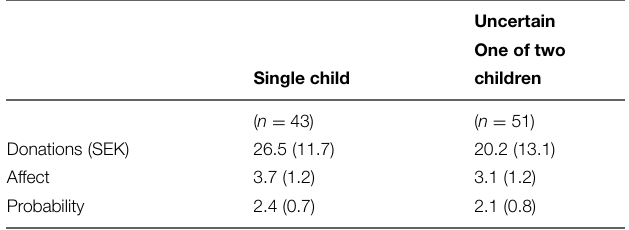
TABLE 1 | Willingness to donate, affect, and probability for uncertain and single